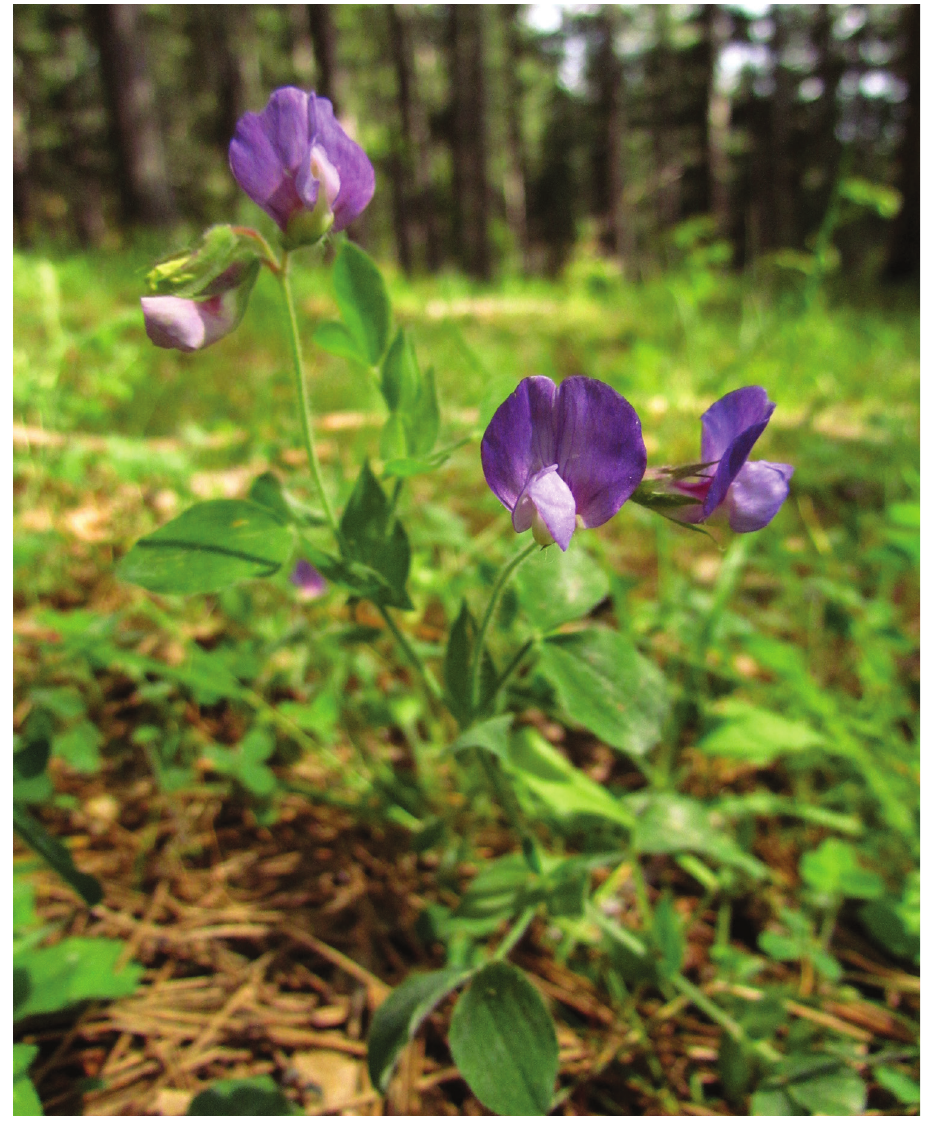
Figure 11. Lathyrus laxiflorus subsp. laxiflorus in Vallone Cecita (1,150 m a.s.l., Longobucco, Cosenza, Italy). Photograph by C.